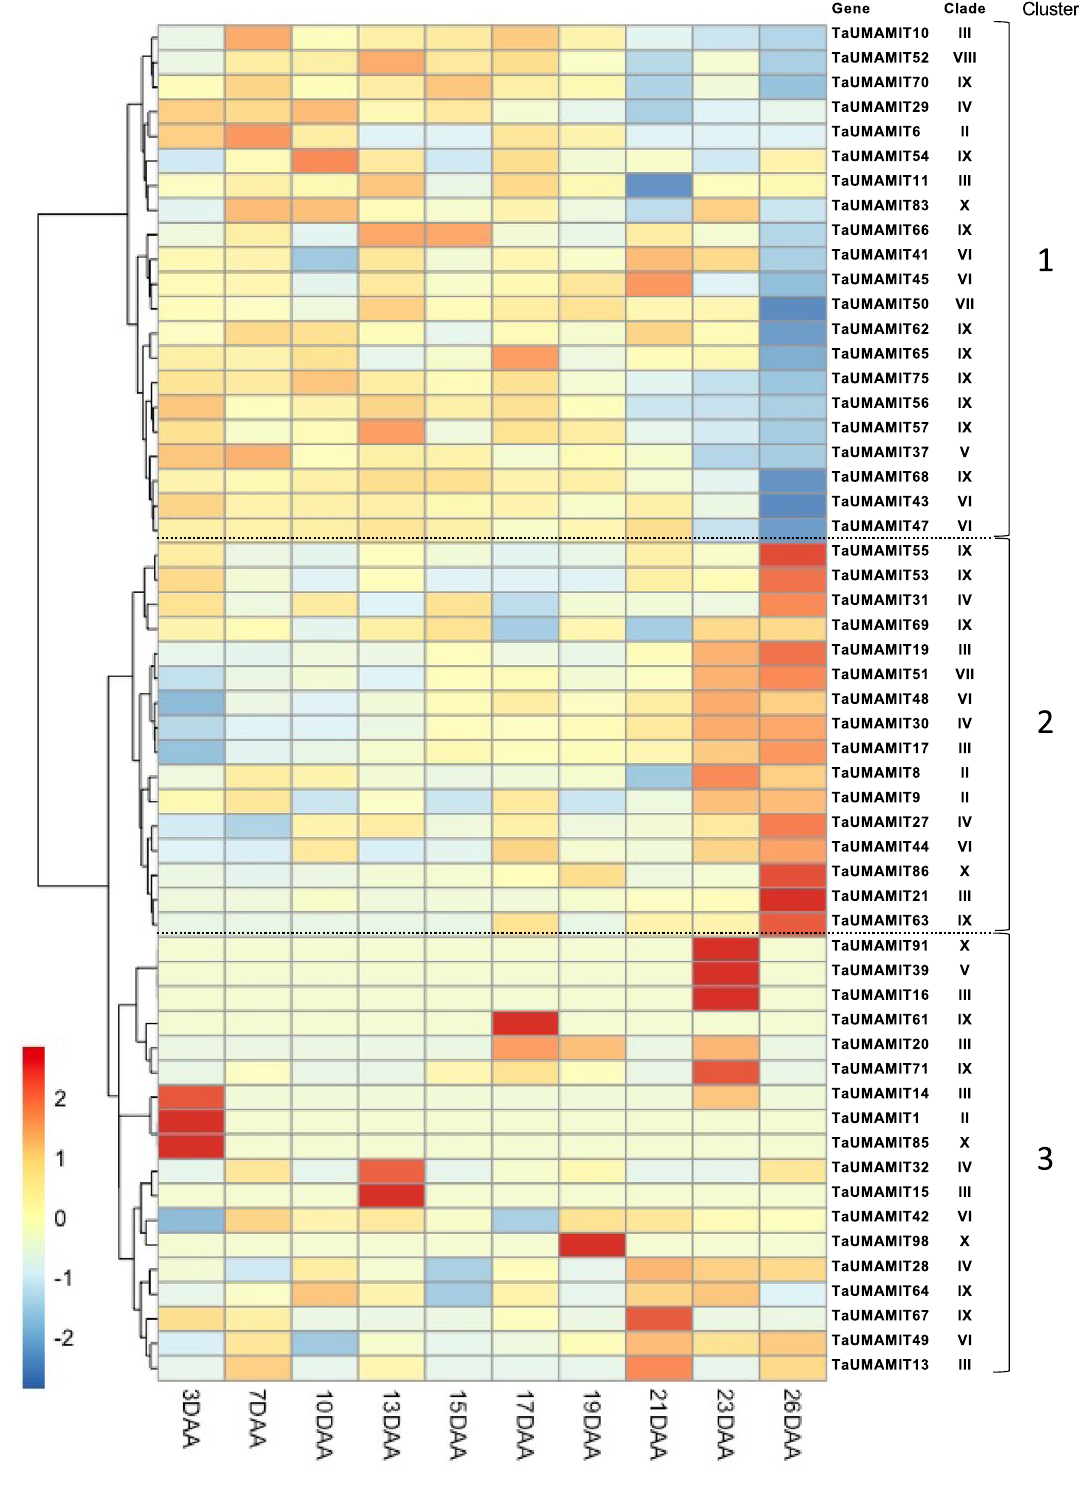
Figure 5. TaUMAMIT expression in senescing leaves. The heatmap is scaled by row (each gene). For each gene, the expression values were averaged for all representing wheat subgenomes. DAA Days after